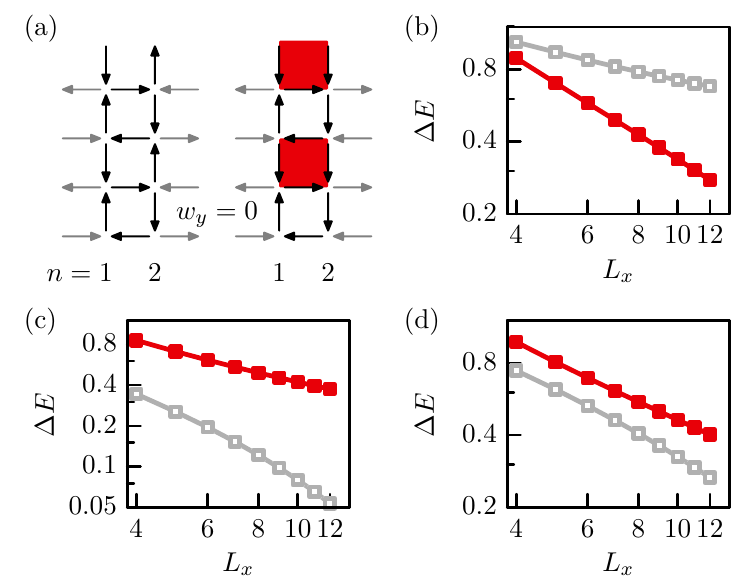
Figure 12: (a) Two choices of boundary conditions (grey arrows) illustrated on a 2 × 4 lattice (left: ‘aligned’, right: ‘anti-aligned’). ‘Anti-aligned’ conditions pre- vent oriented plaquettes from fully covering one of the two sublattices (red) in the = 0. [ (b)-(d) ] Energy gap (in log-log ground-state sector of the winding number, w y = 0 scale) between the two lowest energy states within the ground-state sector w y | = 1 / 2 for odd L × 4 grids. For even L ( | w ), from exactly diagonalized L , red y x x x filled boxes indicate anti-aligned BCs, while grey open boxes indicate aligned